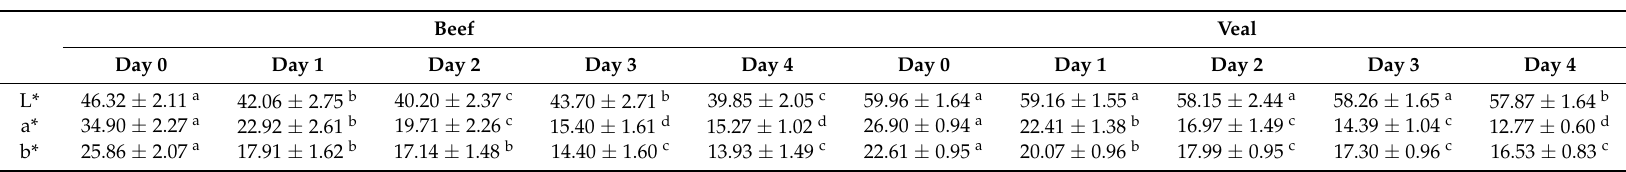
Table 3. Color values (L*, a*, and b*) of the external parts of course ground beef and veal patties stored aerobically at 4.0 ◦ C for four days in foam trays that were covered with air-permeable plastic film.